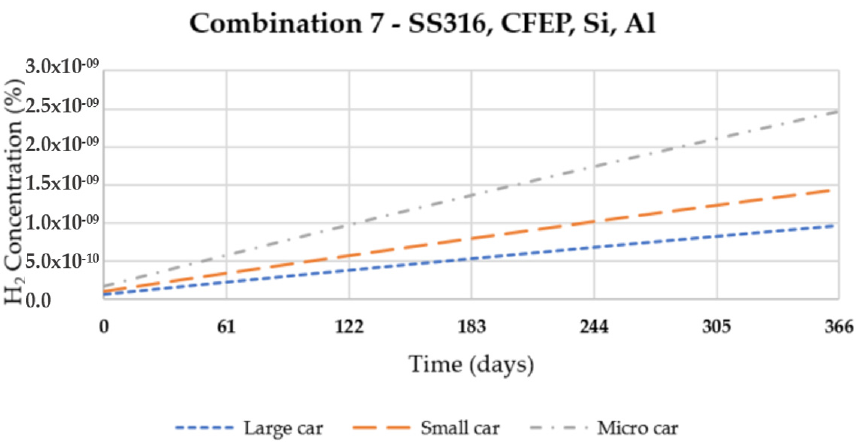
Figure 6. H 2 concentration in the garage, combination 1 from Table 3.